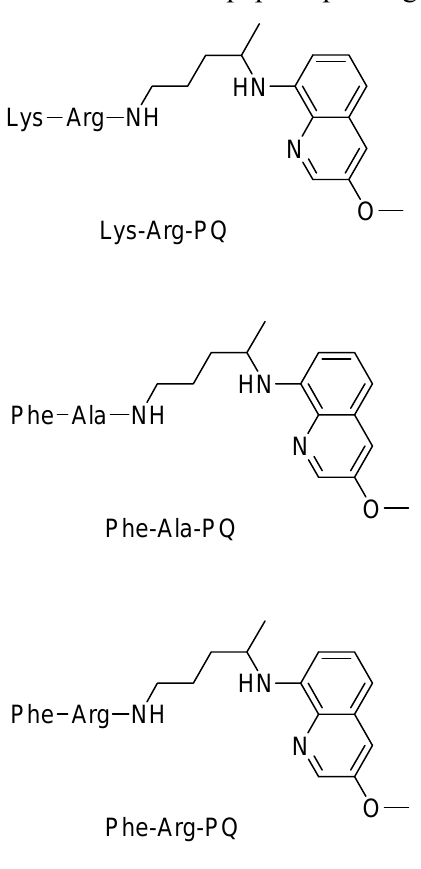
Figure 2. Chemical structures of dipeptide prodrugs of